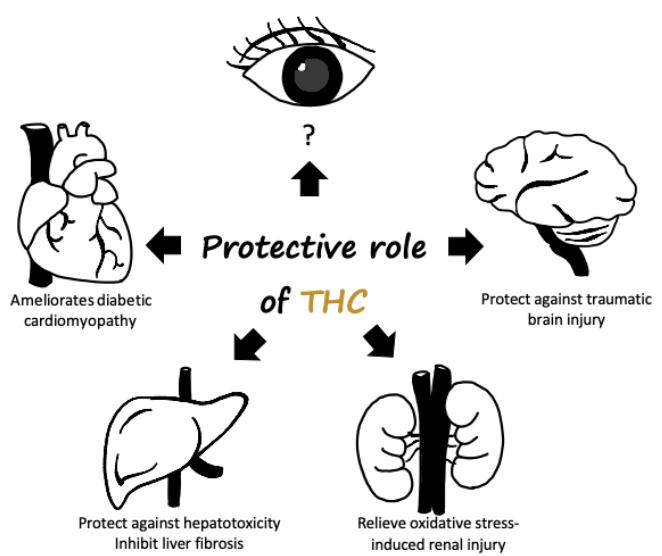
Figure 3. Potential protective role of tetrahydrocurcumin in the human body. THC administration may ameliorate diabetic cardiomyopathy and renal damage. In addition, THC is observed to possess superior hepatic-protective effects and the antiautophagic effect was shown to participate in brain trauma after THC administration.